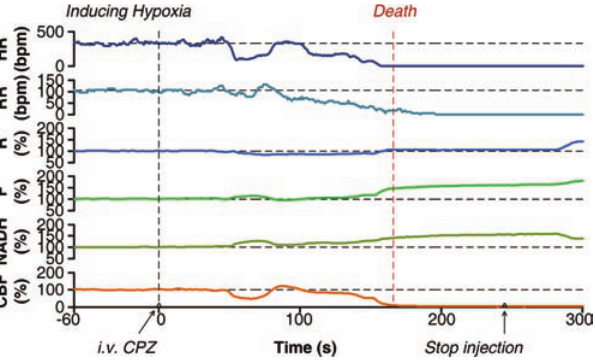
Fig. 4. Typical demonstrations of multiparametric monitoring during the procedure of histogenous hypoxia. The rat was iv injected 125 mg/kg CPZ at the time point